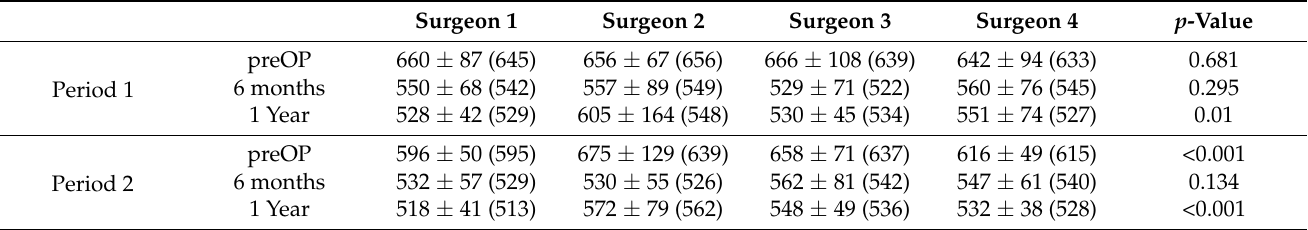
Table 4. Clinical results * after DMEK and Triple-DMEK for each surgeon—CCT ( µ m). Surgeon 1 Surgeon 2 Surgeon 3 Surgeon 4 p -Value